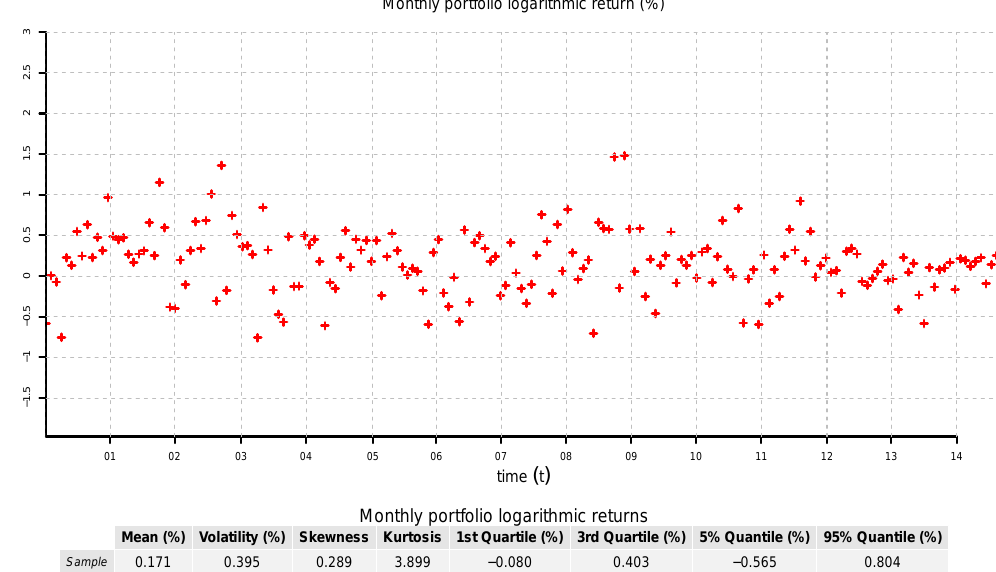
Figure 19. Logarithmic monthly returns of a buy and hold portfolio investing in equal wealth proportions in the zero-coupon bonds with times to maturity of 2, 3, 4, 5, 6 and 9 months and 1, 2, 3, 5, 7 and 10 years. For each monthly period, we calculate the logarithmic return of this portfolio assuming that at the beginning of each period, we are invested in the bonds with these times to maturity in equal proportions of wealth. Table 1. Statistics computed from simulations of the test portfolio returns for some of the monthly periods in the Vasiˇcek model. For each monthly period, we simulate 10 4